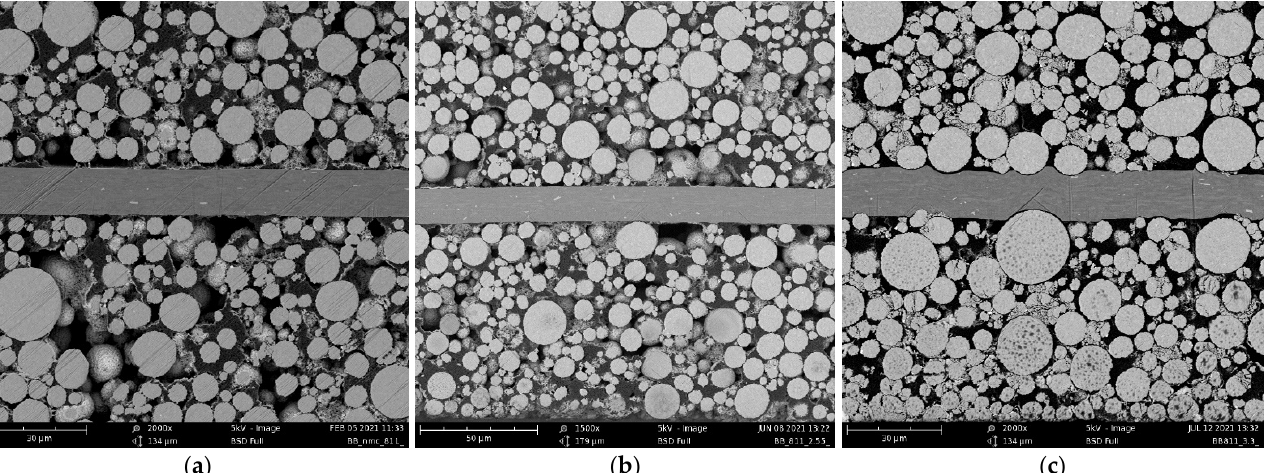
Figure 3. SEM cut of NMC811 cathode ( a ) uncalendered—2000× magnification, ( b ) calendered, 2.55 g/cm³—1500× magnification, ( c ) calendered, 3.3 g/cm³—2000× magnification